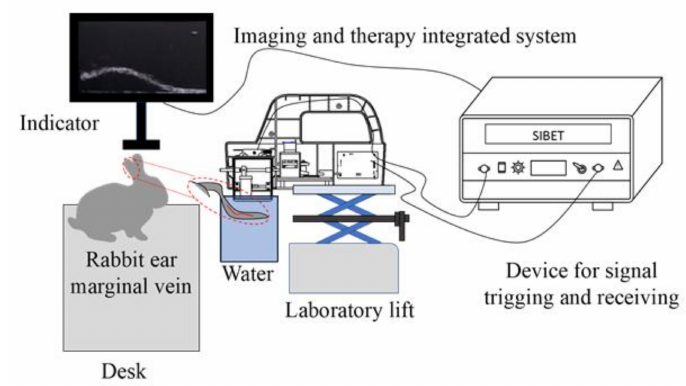
Figure 8. The experimental platform of rabbit marginal ear veins.